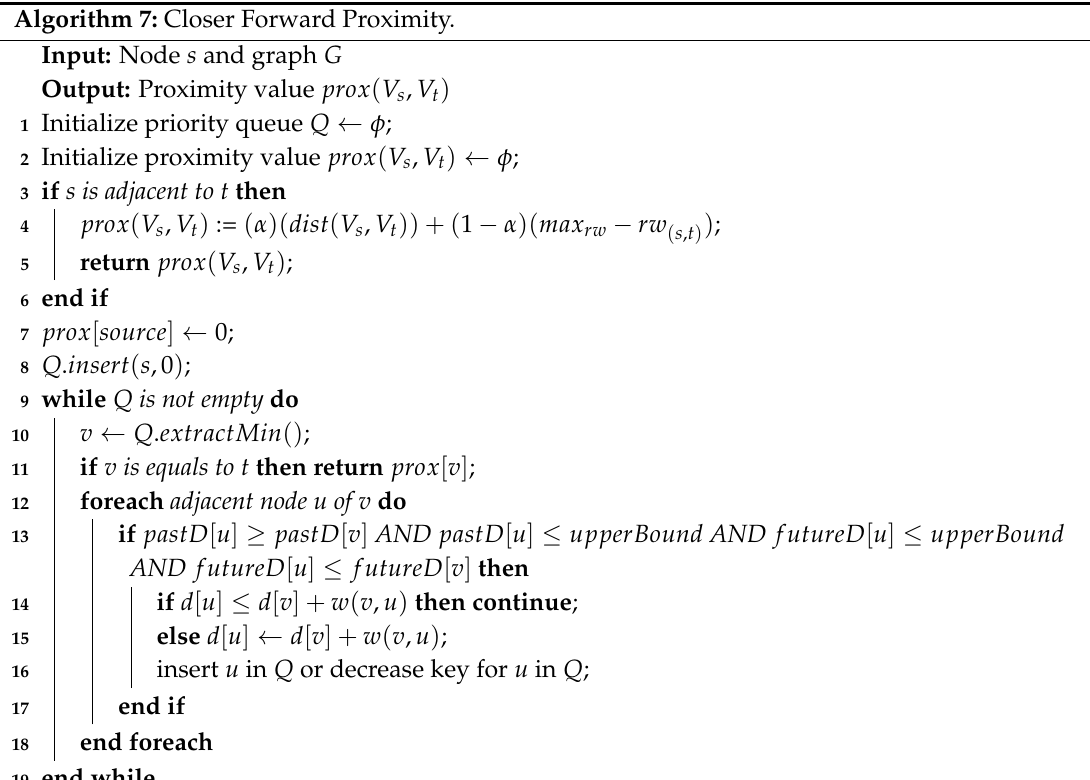
Algorithm 7: Closer Forward Proximity.